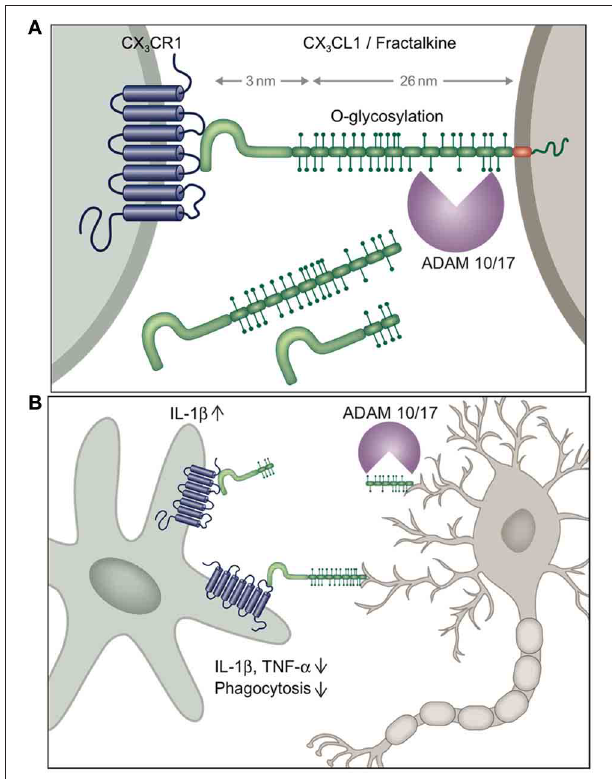
FIGURE 1 | (A) Schematic of CX 3 C chemokine family and (B) potential scenario of differential outcomes of neuronal shed and membrane-anchored CX 3 CL1 engagement by microglia inducing or suppressing microglial IL-1 β production,